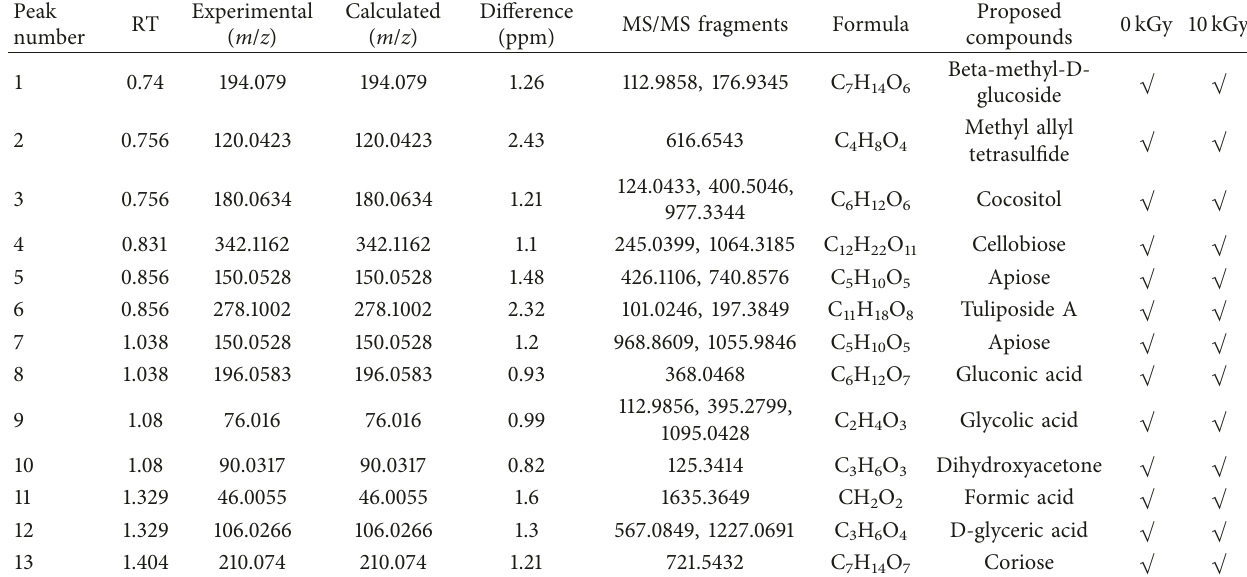
Figure 4: Principal component analysis (PCA) of nonirradiated and irradiated saffron. Note . n : nonirradiation group; n -110 kGy irradiation for 5h; n -2 10kGy irradiation for 10h ( n � 1–10, number of the 10 batches of samples). Table 1: Chemical components identified from nonirradiated and irradiated